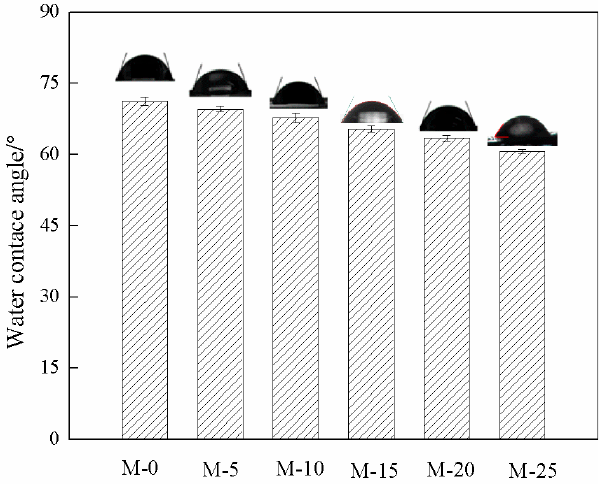
Figure 8. Water contact angle of mixed matrix membranes.